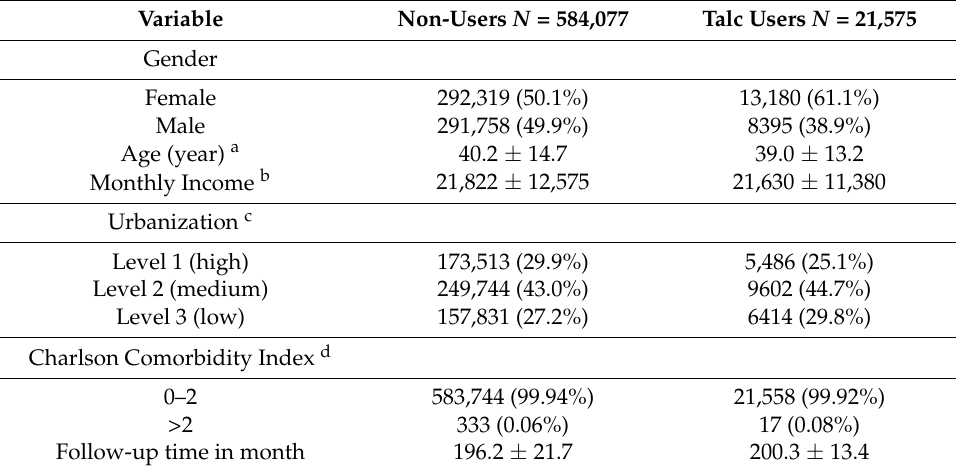
Table 1. Characteristics of study base at enrollment.